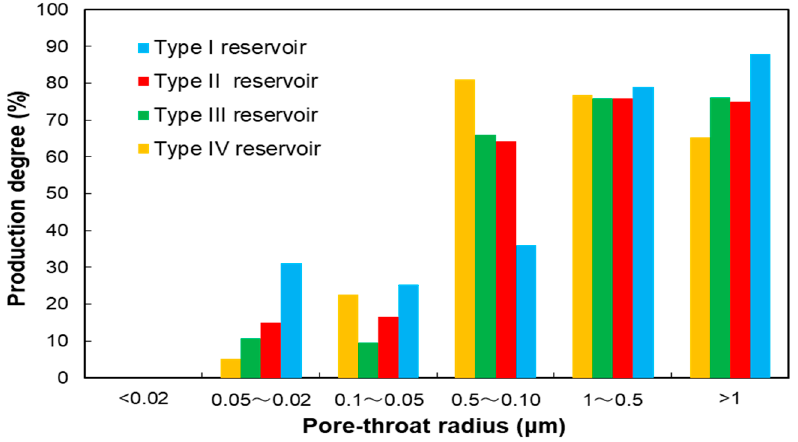
Figure 11. Producing degree of crude oil in the pores and throats of different types of reservoirs.